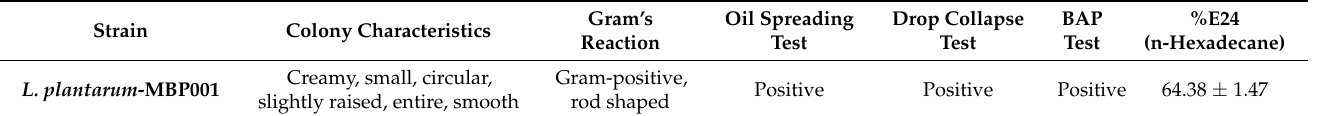
Table 1. Qualitative and quantitative results of different screening assays for the production of a biosurfactant (values are representatives of mean ± SD (n =